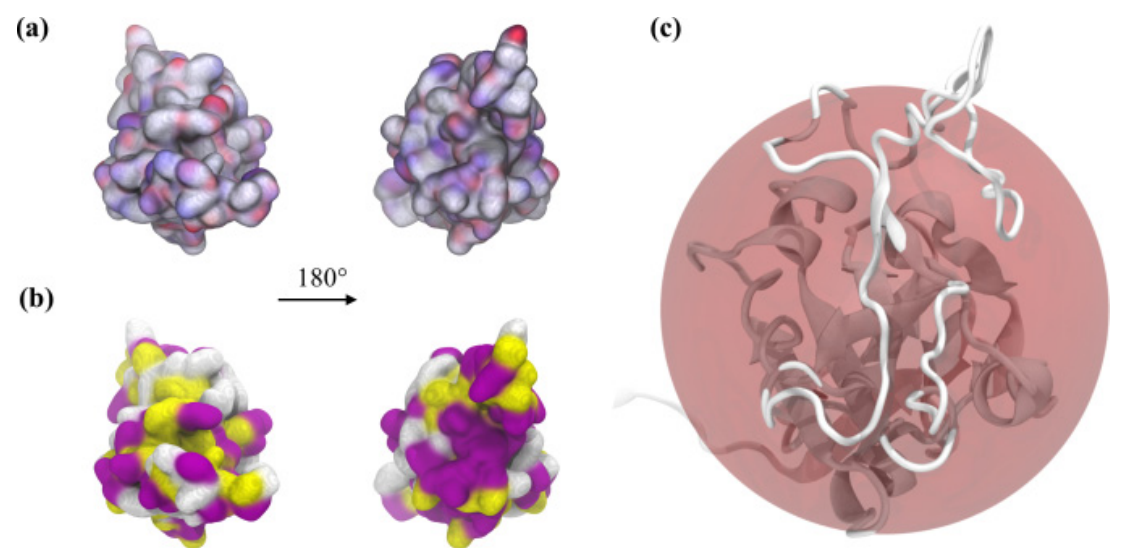
Figure 2. ( a , b ) correspond to the charge and polarity distribution of S1R domain, respectively. In ( a ), positive and negative charges are highlighted in blue and red, respectively. In ( b ), the polar and nonpolar amino acids are highlighted in violet and green, respectively. ( c ) S1R domain inscribed in the sphere of diameter 3.84 nm, see Table 2.